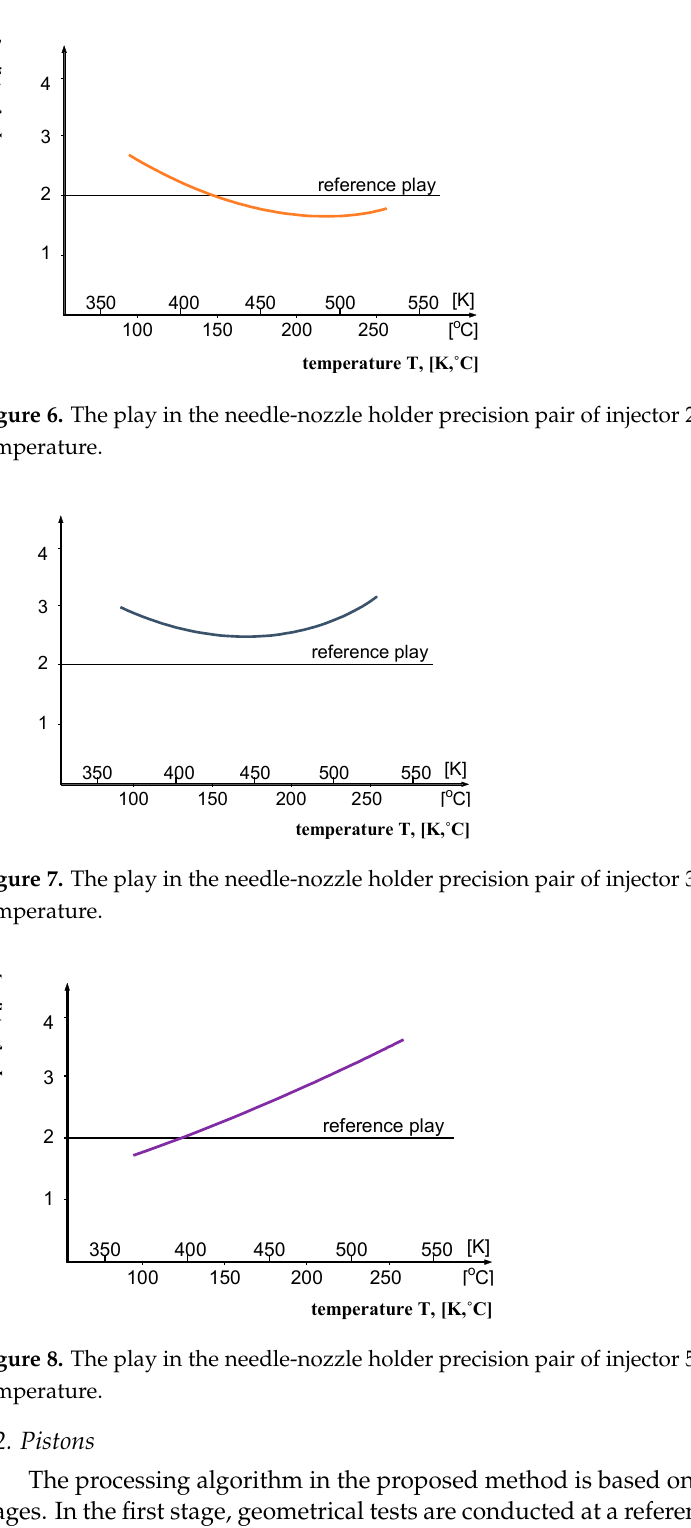
Figure 9. Measurement points on the individual piston grades (results contained in Table 1).